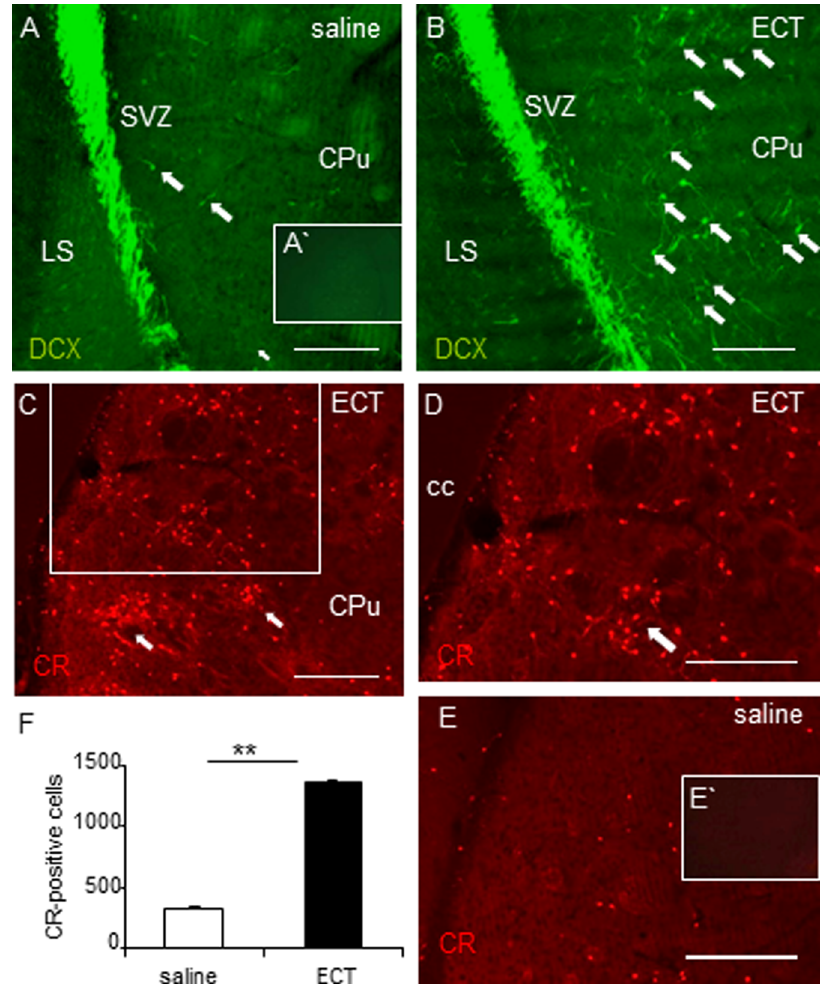
Figure 2. ECT increases the total number of both DCX-positive neuroblasts and CR-positive interneurons in the rat striatum. (A,B) Significant increase in the number of DCX-positive cells (green) in the medial striatum ( arrows ) in comparison to controls (A) in ECT-treated animals (B) 10d after the BrdU treatment. (A) No specific staining was visible in control sections processed only with the secondary antibody. (C–E) ECT augments the number of CR-positive interneurons (red) often grouped in clusters ( arrows ) in the dorso-medial striatum (C, D is an insight of C) compared to controls (E). (E) No specific staining was visible in control sections processed only with the secondary antibody. (F) Quantitative analysis of the CR expression in ECT-treated vs. control animals. Statistical differences determined by Mann-Whitney U test (0.001 , **p , 0.01). Scale bars: 200 m m. CPu, caudate-putamen; LS, lateral septum; SVZ, subventricular zone.